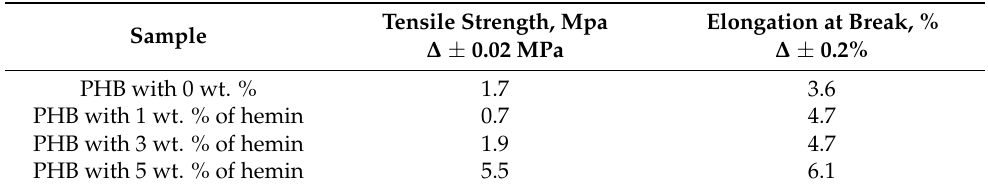
Table 2. Results of the physical and mechanical tests of the samples with different content of the